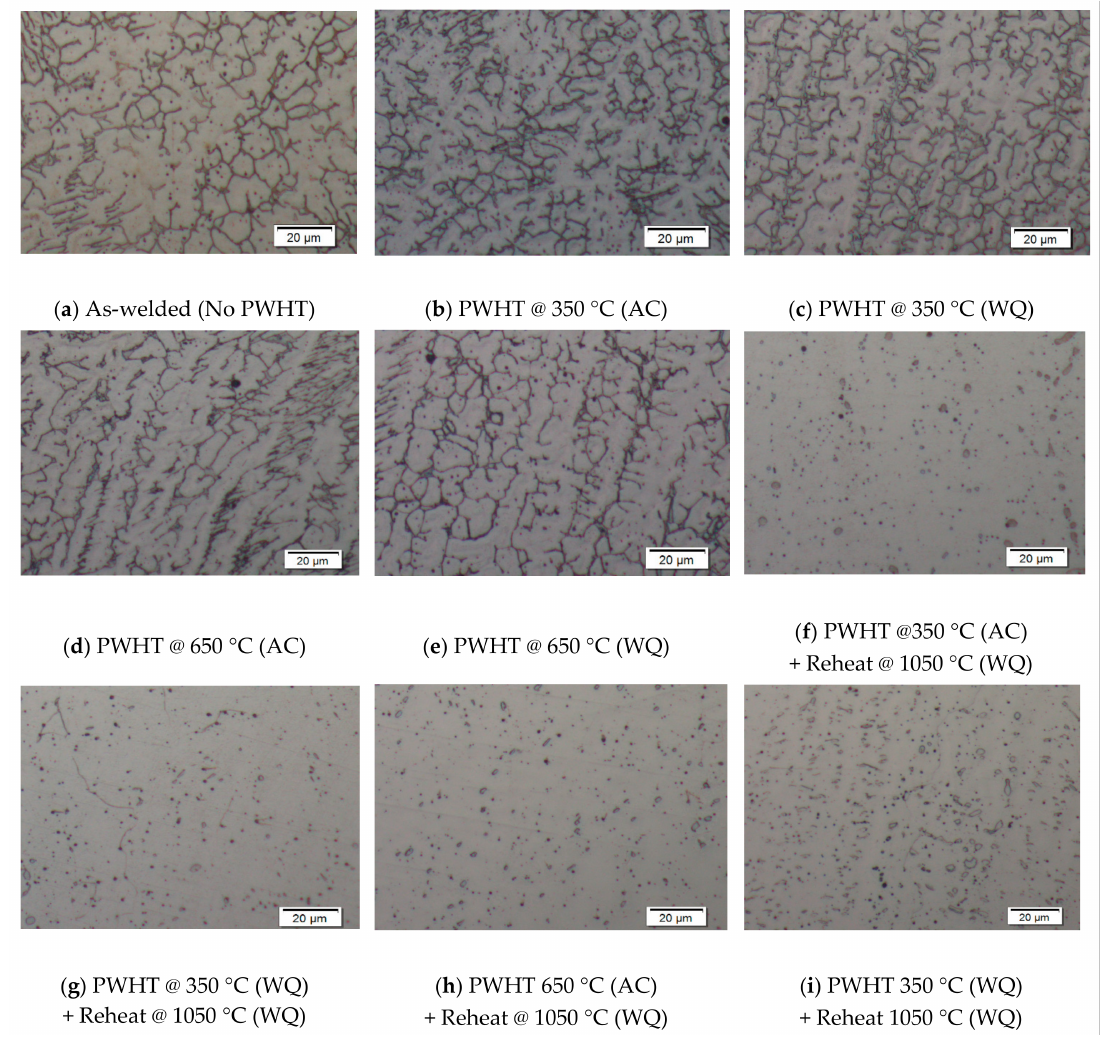
Figure 3. SEM Image of at fusion zone with three different heat treatments (Dark phase ferrite, white